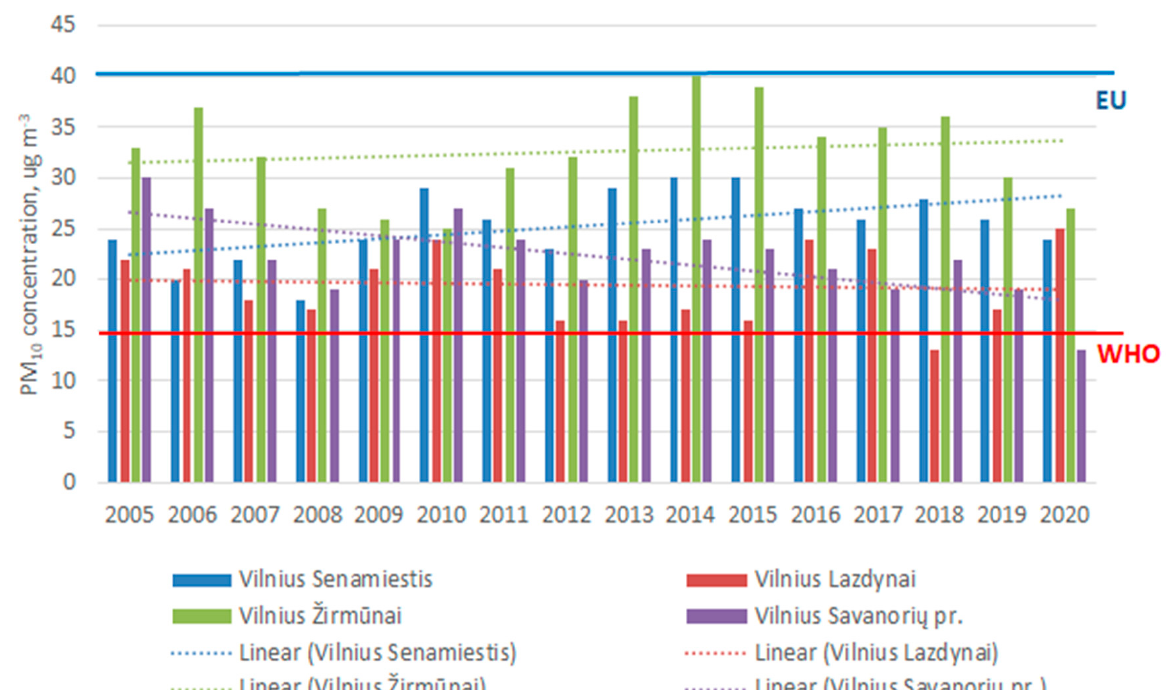
Figure 9. Annual mean PM 10 concentration and trends in Vilnius sites. Table 4. The overall values of the annual PM 10 (PM 2.5 ) trend were observed along standard devia- tion